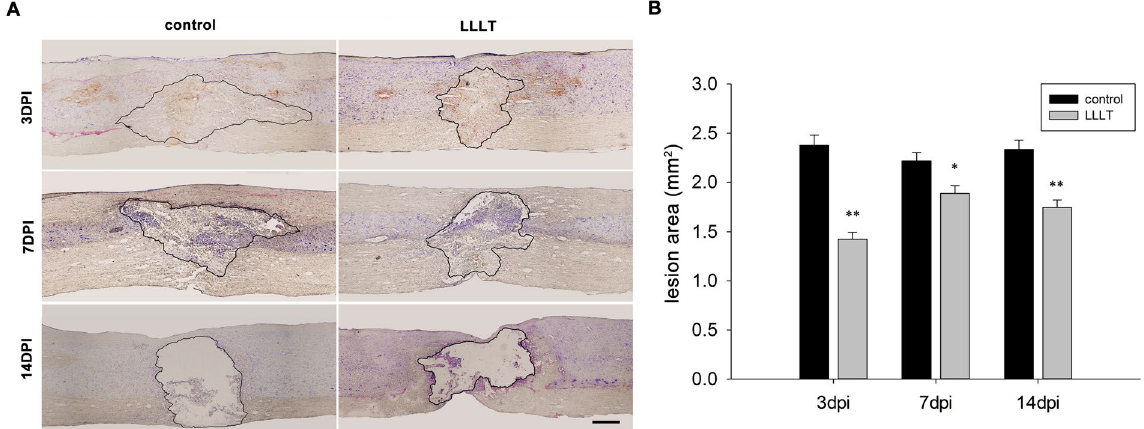
Figure 8. LLLT shrinks the SCI lesion area. ( A ) Representative images of lesion profile and cavitation in control and LLLT groups at 3, 7, and 14 dpi, respectively. The lesion area and cavity are outlined according to Nissl staining with cresyl violet. Lesion assessment was location-matched between the two groups. ( B ) Assessment of lesion and cavity area at 3, 7, and 14 dpi. Bar = 500 μ m. (n = 2 sections per rat with 3 rats per group; * P < 0.05; ** P < 0.01, compared with control).